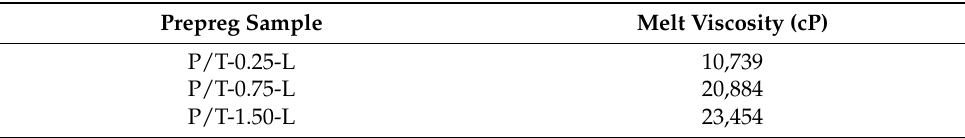
Table 7. Melt viscosity of different